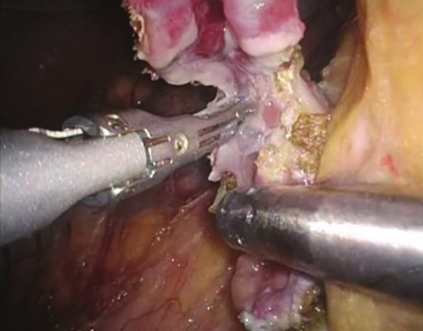
Figure 3: Laparoscopic view of full-thickness incision. After com- pletion of entire circumferential seromuscular layer incision, the affected whole layer was dissected along sero-muscular layer inci- sion circumferentially, using an ultrasonically activated device.